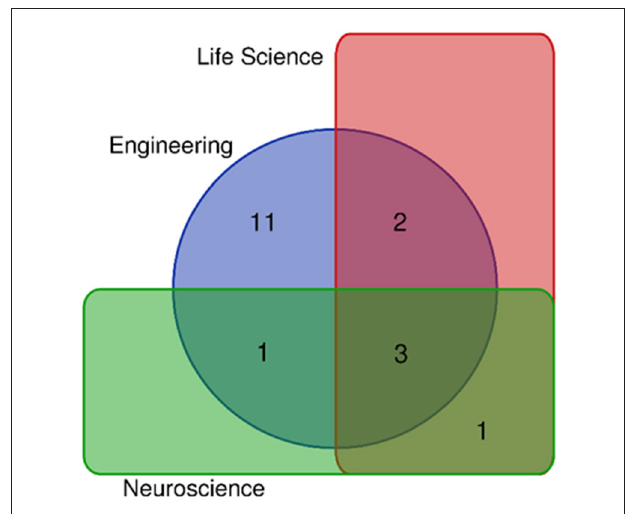
FIGURE 1 | Distribution of the contributions across